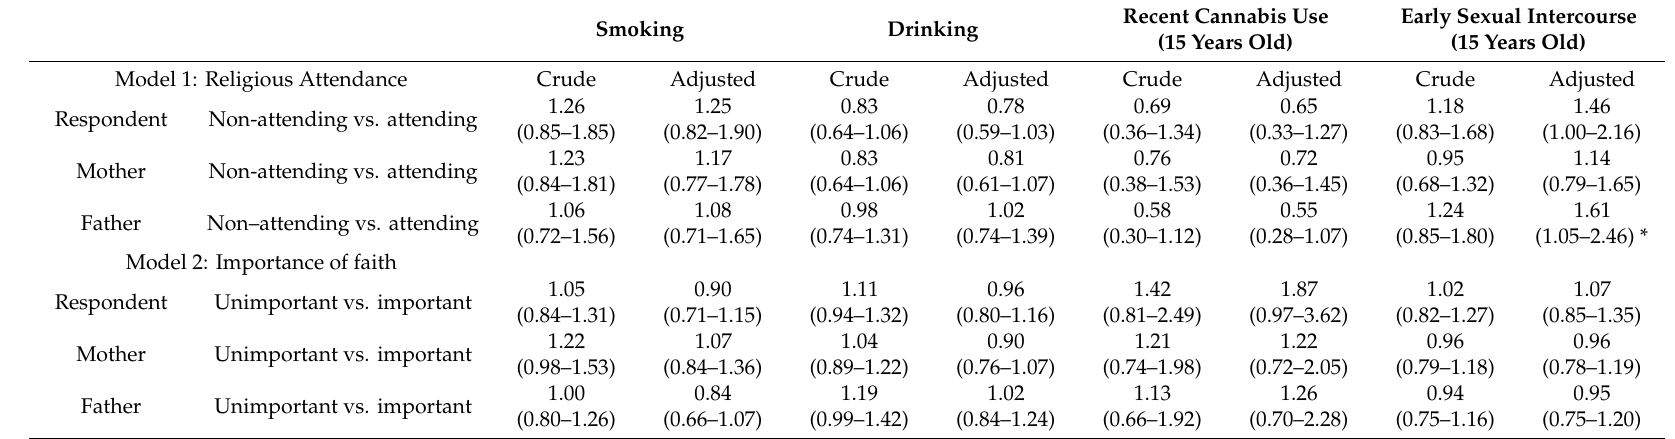
Table 2. Associations of adolescent smoking, drinking, recent cannabis use, and early sexual intercourse with religious attendance, importance of faith, crude and, adjusted for age, gender, socioeconomic status (FAS), and social media use (odds ratios and 95% confidence